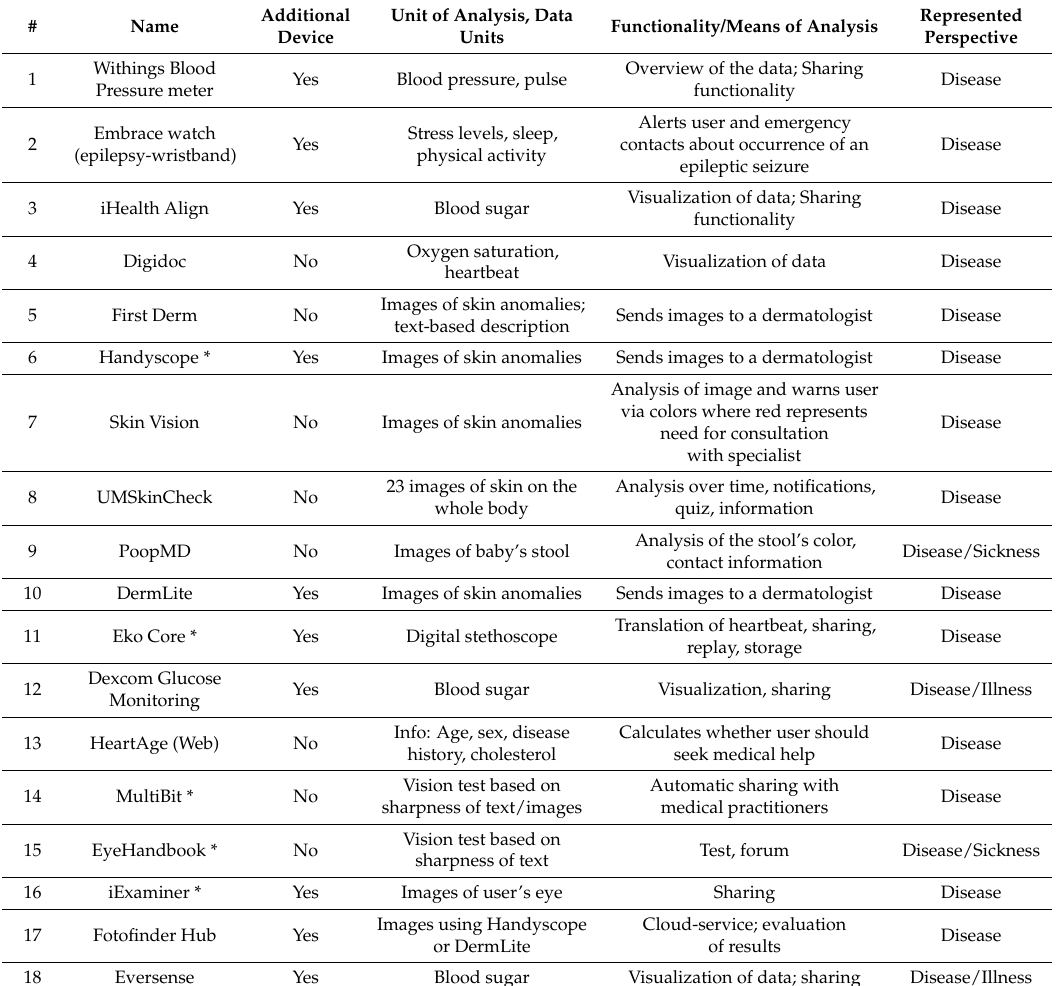
Table 2. Overview of the health applications suggested by NTC. Applications developed with medical practitioners as intended users are marked with